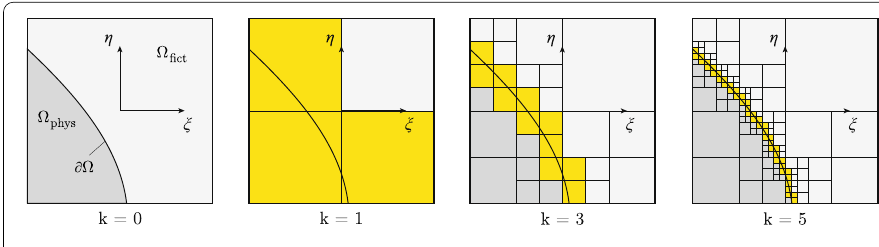
a specific example in form of the cell stiffness matrix is given in Eq. (9). Since the aim